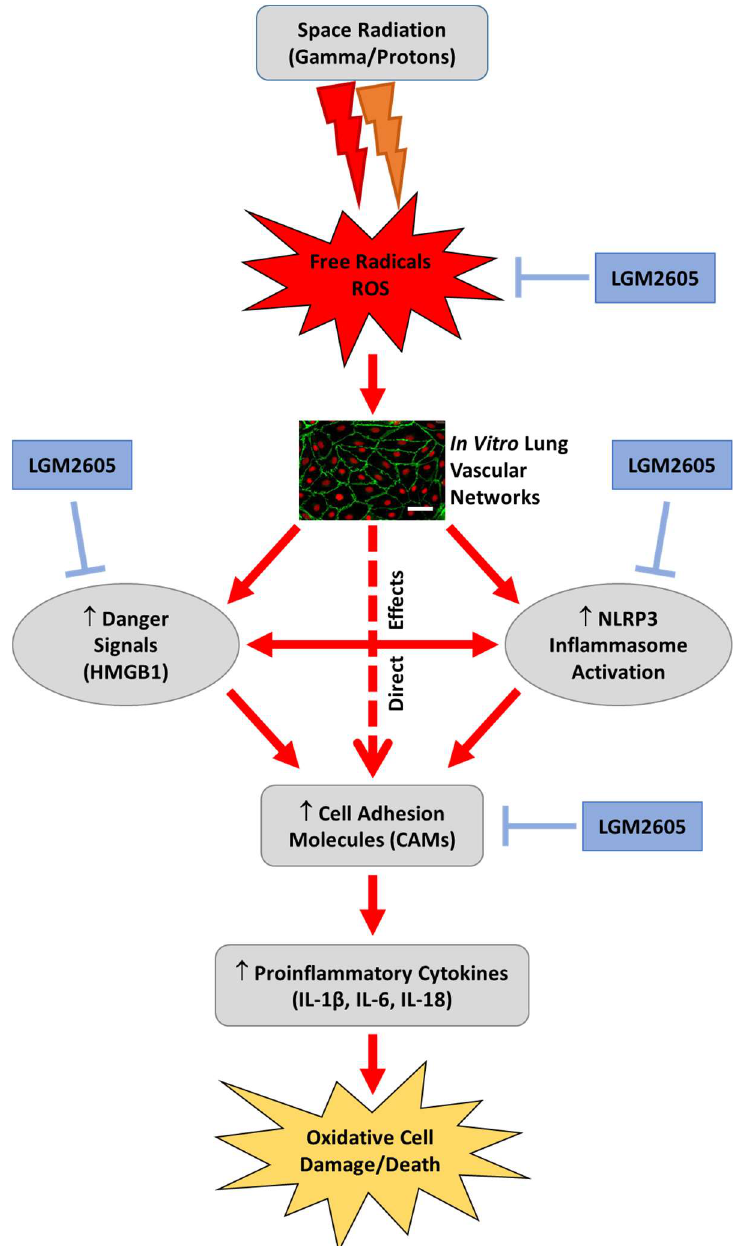
Figure 11. Proposed mechanism of space radiation-induced inflammation and mitigation by LGM2605 in in vitro lung vascular networks (flow-adapted endothelial cells). Space radiation exposure leads to the production of free radicals and reactive oxygen species (ROS), which ultimately activate the NLRP3 inflammasome, increase cellular adhesion molecules, and increase danger signaling molecules, such as HMGB1. LGM2605 mitigates the detrimental effects of space radiation exposure by scavenging free radicals and ROS, and subsequently blocking NLRP3 inflammasome activation and ICAM-1 expression. Scale bar = 20 µm.